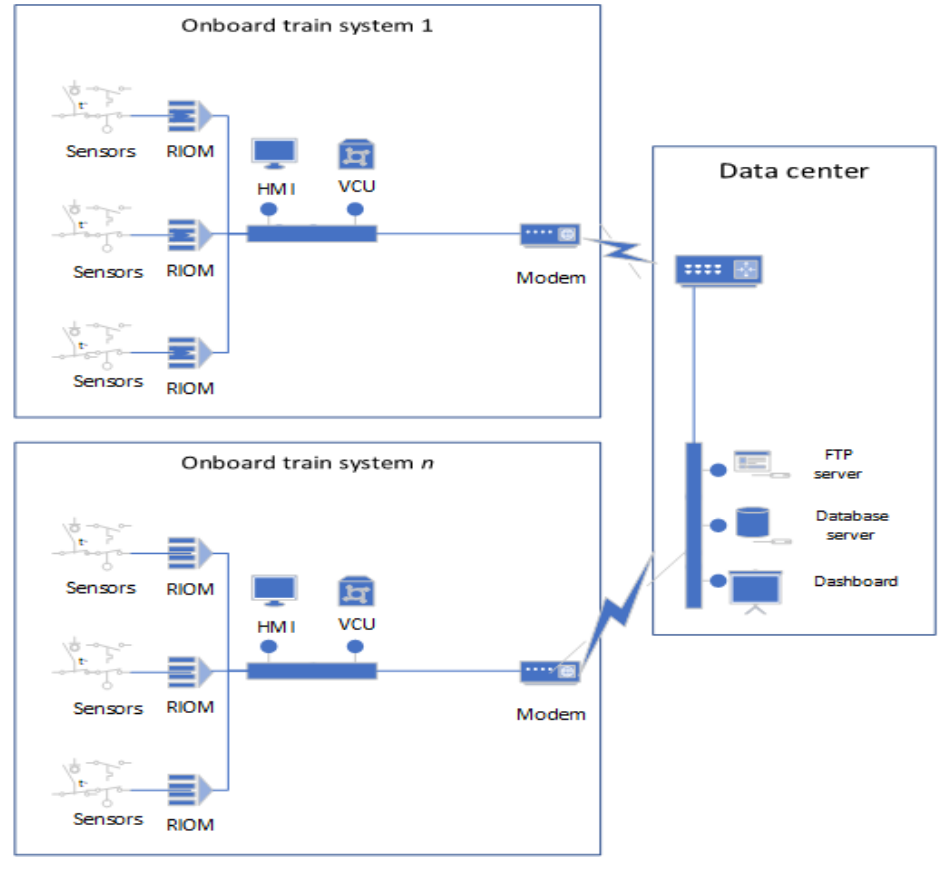
Figure 1. Existing TCMS model without security function.